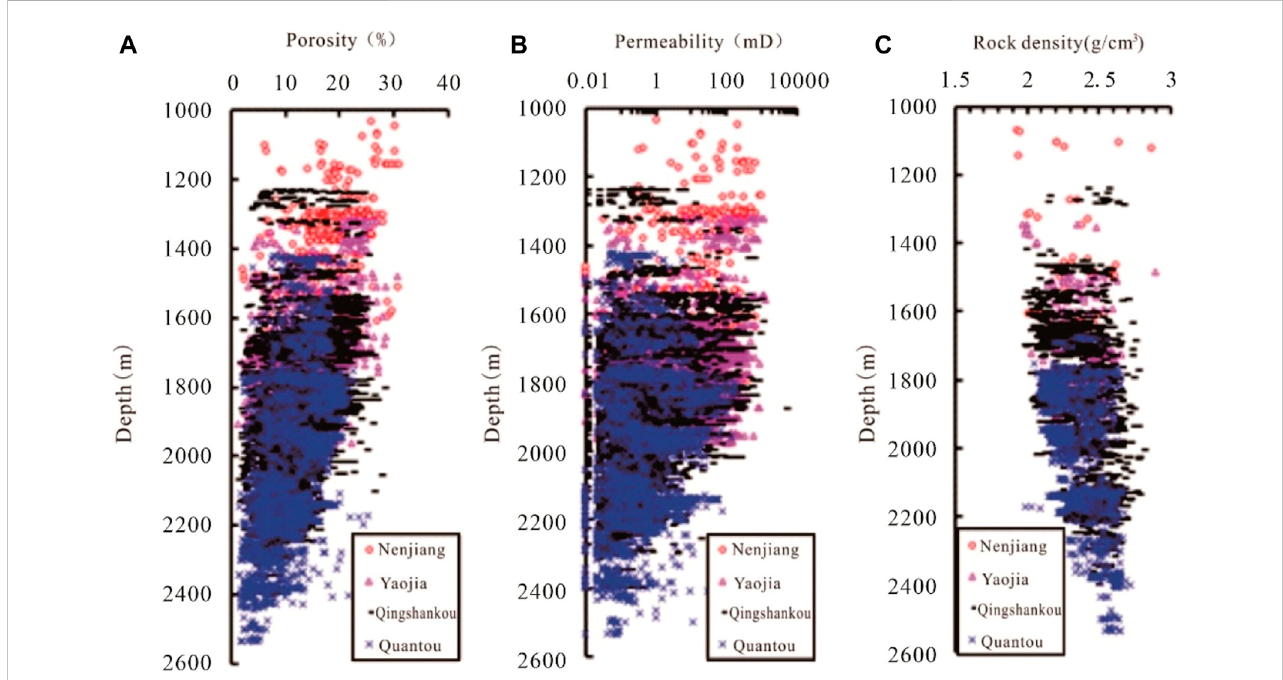
FIGURE 11 Variation of (A) porosity, (B) permeability, and (C) rock density of tight sandstone reservoirs with depth in the Qijia area.